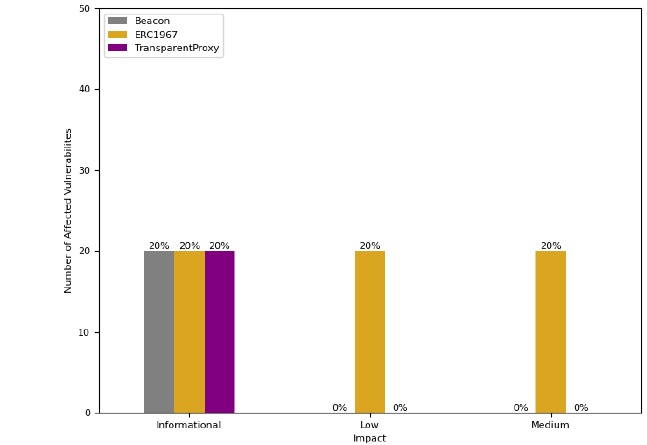
Figure 9. The number of affected vulnerabilities based on OpenZeppelin patterns